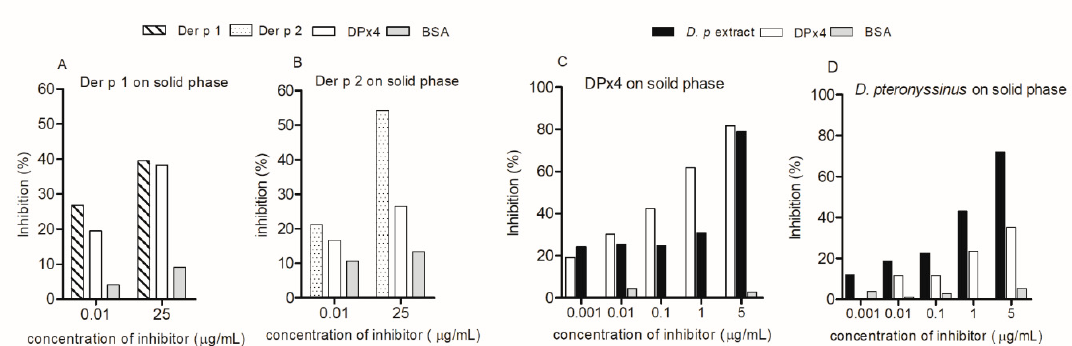
Figure 4. ELISA inhibition results. The percentage of inhibition of IgE reactivity of serum pools by DPx4 to Der p 1 ( A ), Der p 2 ( B ), and DPx4 ( C ). Inhibition of IgE reactivity to D. pteronyssinus extract by DPx4 ( D ). Homologous inhibitor and bovine serum albumin (BSA) were used as controls. Dp : D.